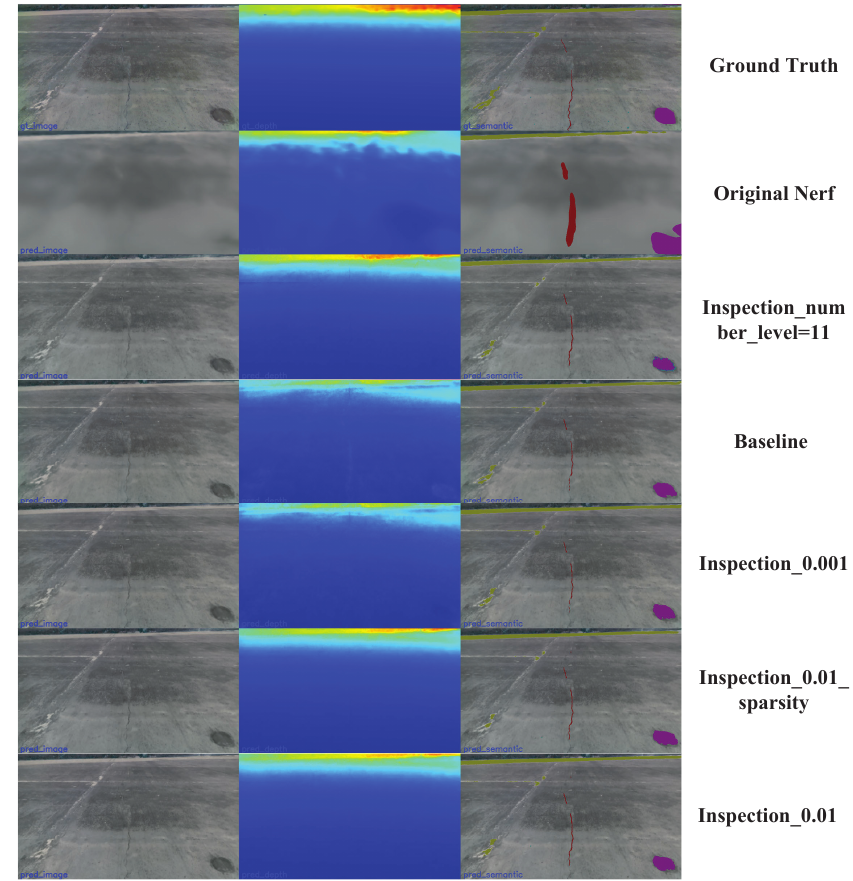
Figure A1. All model rendering result comparison of a validation